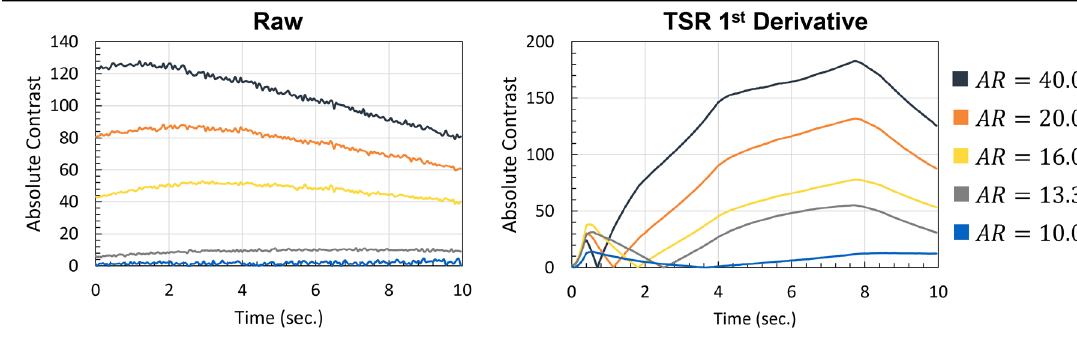
Figure 7. Evolution of the absolute contrast of the 20 mm flat-bottom holes during the transient cooling phase for the raw thermograms and thermograms pre-processed using the TSR algorithm (1st